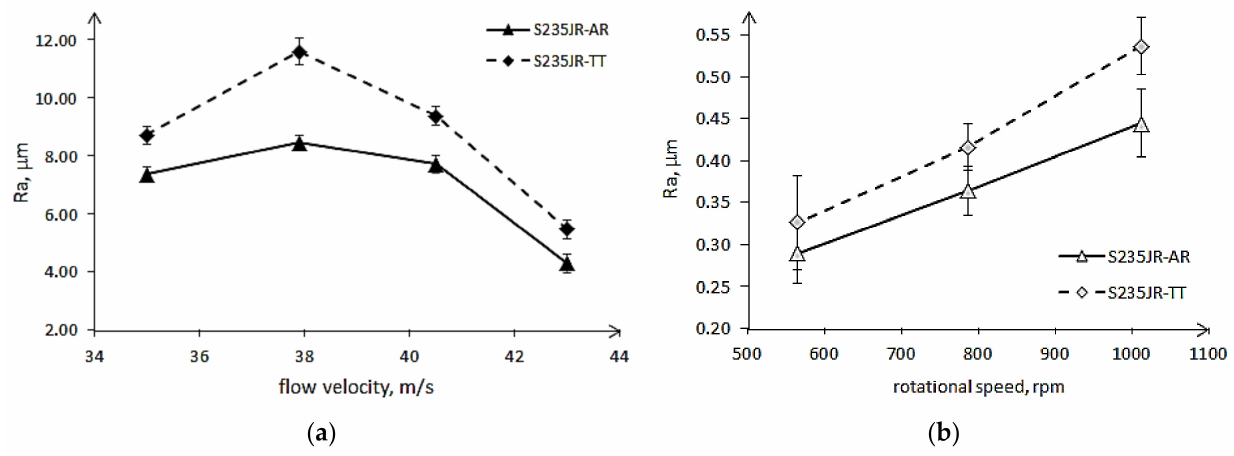
Figure 21. Correlation between ( a ) the maximum Ra parameter and a flow velocity in cavitation erosion tests, and ( b ) the mean Ra parameter and a rotational speed in slurry erosion